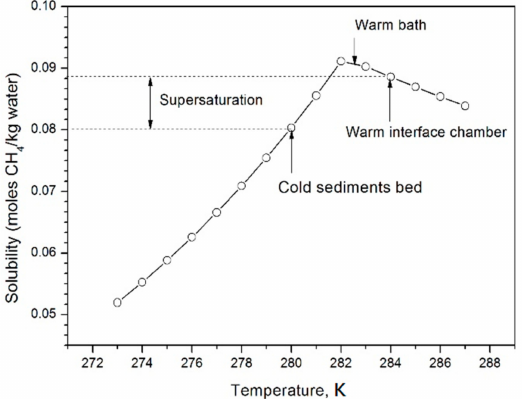
Figure 3. Methane solubility in brine calculated by Duan’s model [30].